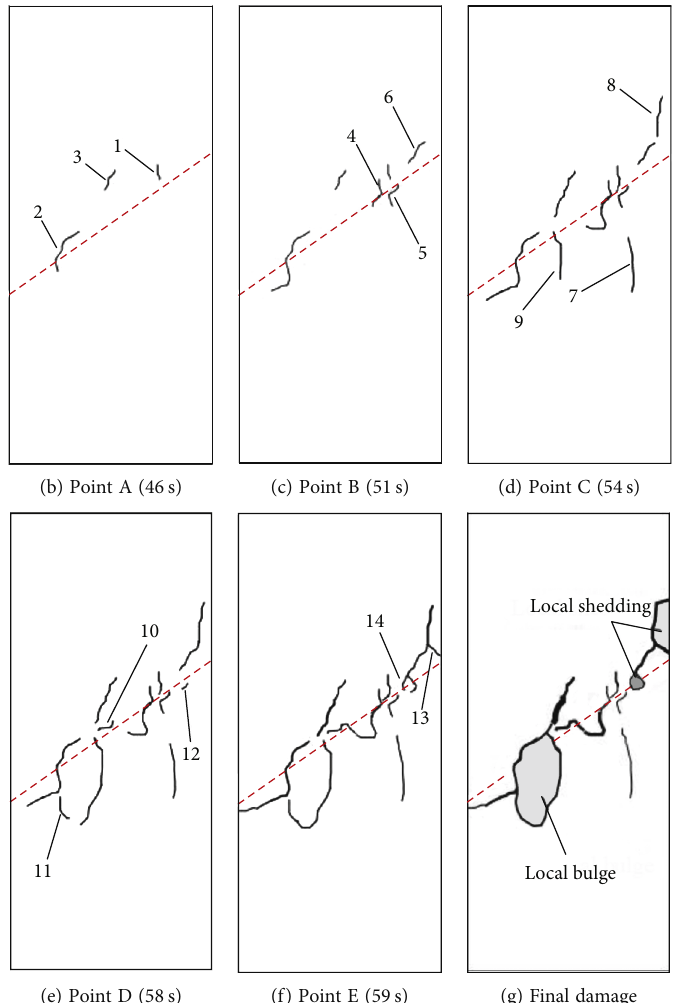
Figure 11: Grouted body specimen cracking extension process at a displacement rate of 0.03mm/s and a crack inclination angle of 45 °